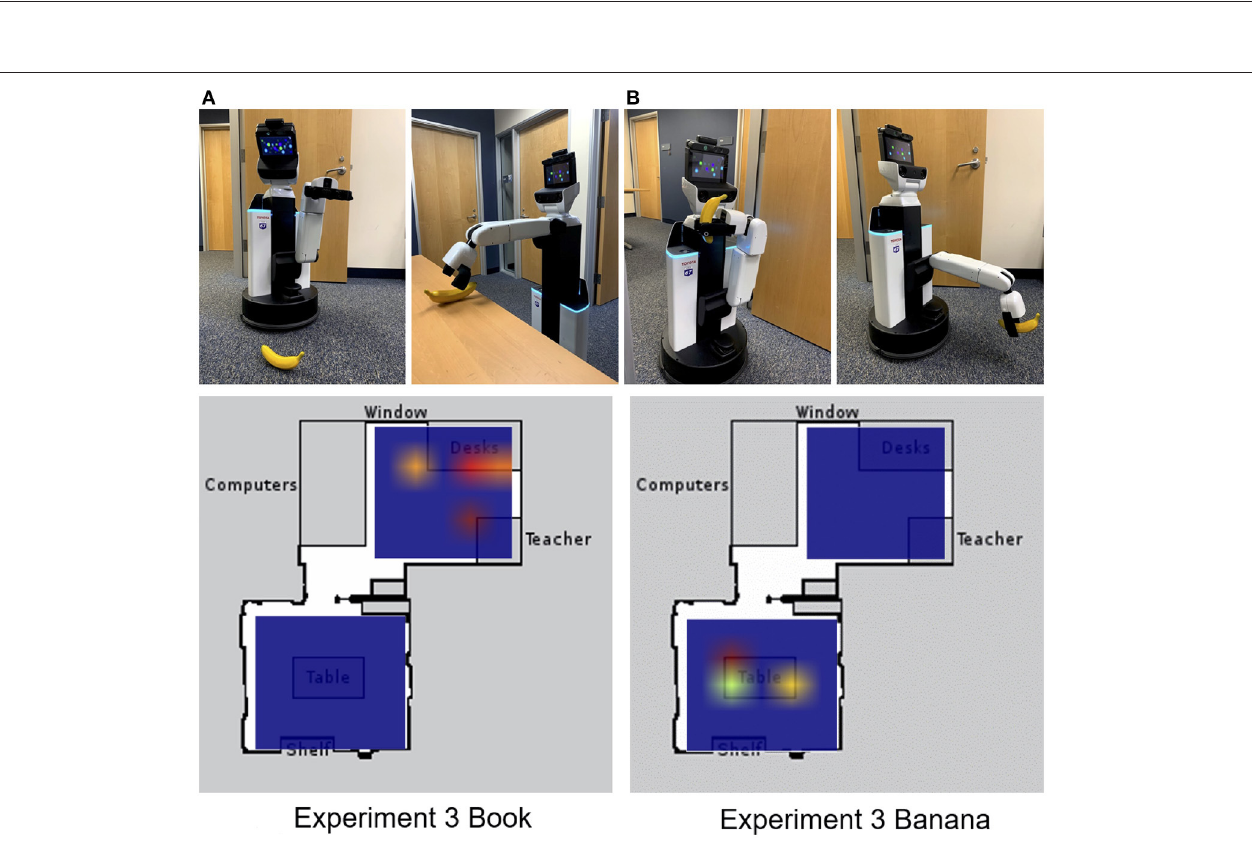
FIGURE 5 | Cuing the robot on objects it had not retrieved before. Top: The robot was shown a banana. The robot then went to the break room to pick up the banana and navigated to the drop-off location to deposit it. Bottom: Heat map of action layer during experiment 3. (A) Cued to retrieve a book. (B) Cued to retrieve a banana. Adapted from Hwu et al.